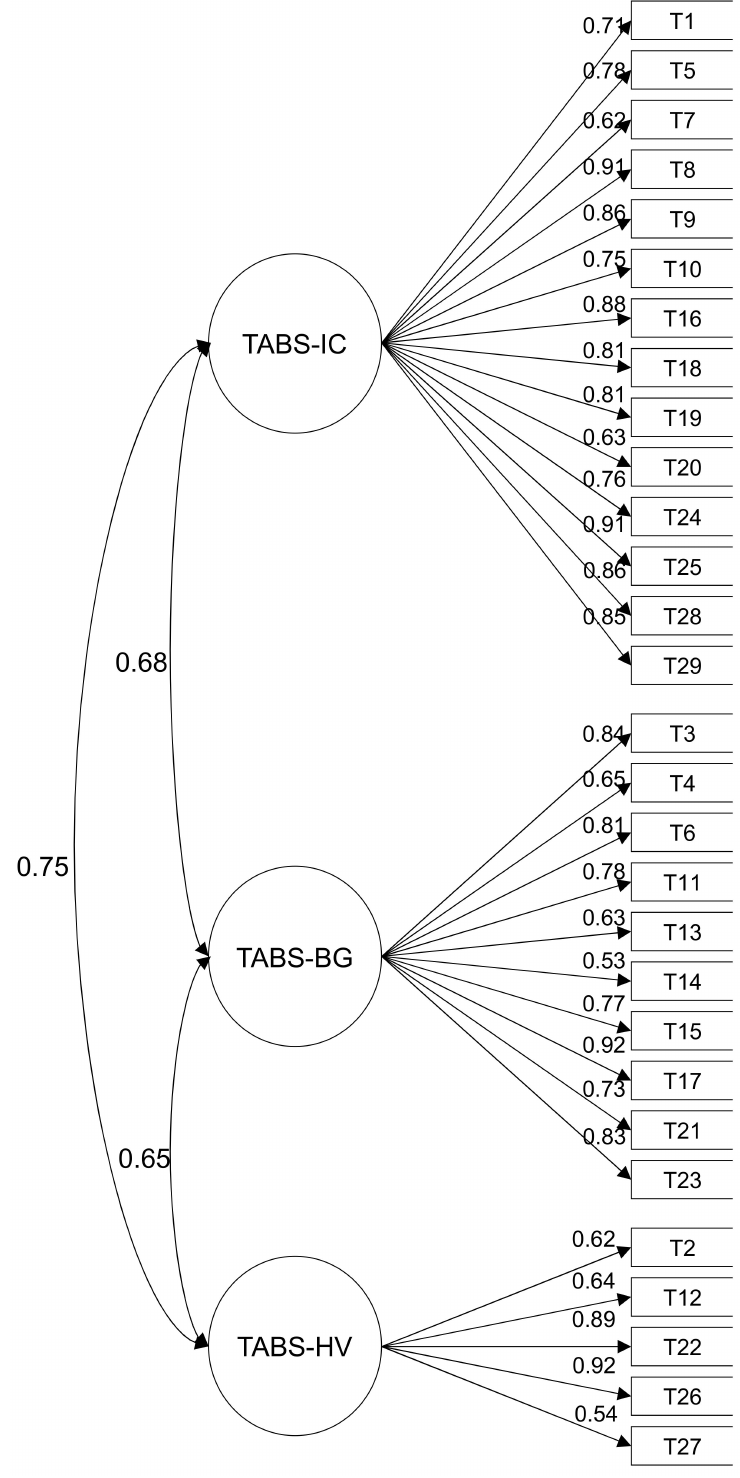
Figure 2. Standardized Factor Loadings for the